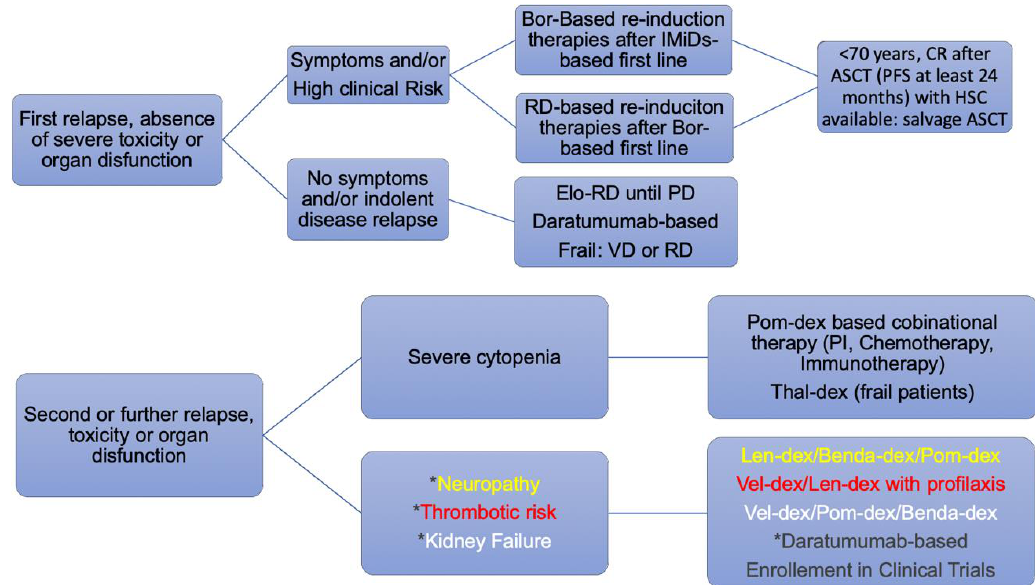
Figure 6. Pragmatic Integrated approach to MM patients according to the clinical risk profile. Bor: bortezomib; RD: REVLIMID® (lenalidomide)-dexamethasone; Elo-RD: elotuzumab® -REVLIMID® (lenalidomide)-dexamethasone; VD: VELCADE ® (bortezomib)-dexamethasone; PI: proteasome inhibitor; Thal-dex: thalidomide-dexamethasone; Len-dex: lenalidomide-dexamethasone; Benda-dex: bendamustine-dexamethasone; Pom-dex: pomalidomide-dexamethasone; Vel-dex: VELCADE ® (bortezomib)-dexamethasone. PI: proteasome inhibitor. PD: progressive disease; CR: complete response. PFS: progression-free survival. HSC: hematopoietic stem cells ASCT: autologous stem cell transplantation.